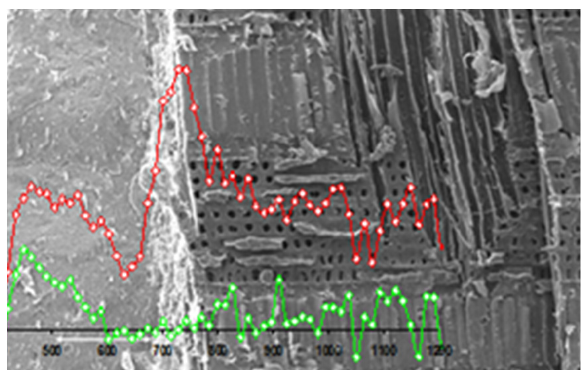
Figure 4. Coating failure due to moisture build up in end grain.